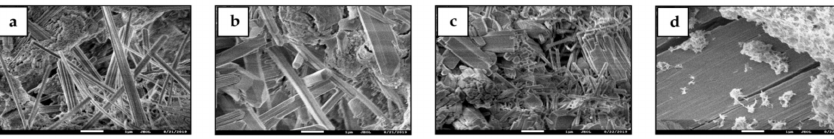
Figure 18. SEM micromorphology of WS-GF-HBSAC-DG cement hydration products at di ff erent curing ages: ( a ) One day; ( b ) 3 days; ( c ) 7 days; ( d ) 28